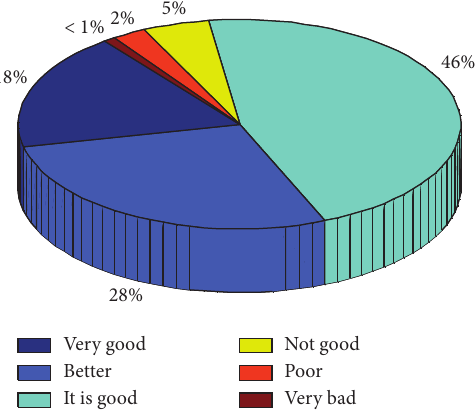
Figure 12: Proportion of CVR inspection data.